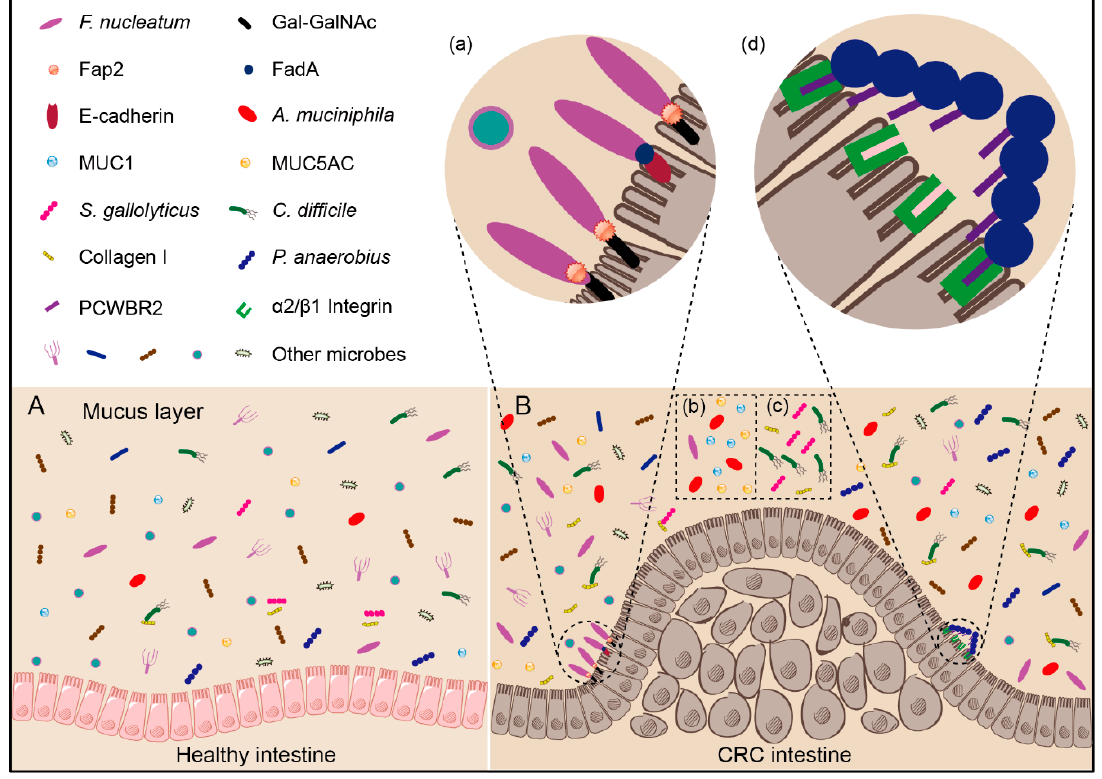
Figure 2. Potential mechanism of bacterial enrichment in CRC tissues. ( A ) Healthy intestine. ( B ) CRC intestine: ( a ) Gal-GalNAc is overexpressed in CRC cells, onto which the Fap2 of F. nucleatum can directly bind, resulting in specific F. nucleatum accumulation in CRC tissues; on the other hand, FadA can help F. nucleatum adhere to E-cadherin of intestinal epithelial cells; ( b ) MUC1 and MUC5AC are increased in the intestine of colorectal cancer patients. Due to the increasing available substrates, the abundance of A. muciniphila in the intestine of colorectal cancer patients is thus increased; ( c ) Collagen I is increased in the intestine of colorectal cancer patients. S. gallolyticus and C. di ffi cile can combine with collagens I, resulting in increased abundance in the intestine of colorectal cancer patients; ( d ) The surface protein PCWBR2 of P. anaerobius can directly interact with the colorectal epithelial cell via α 2 / β 1 integrin, which is frequently overexpressed in CRC tissues.